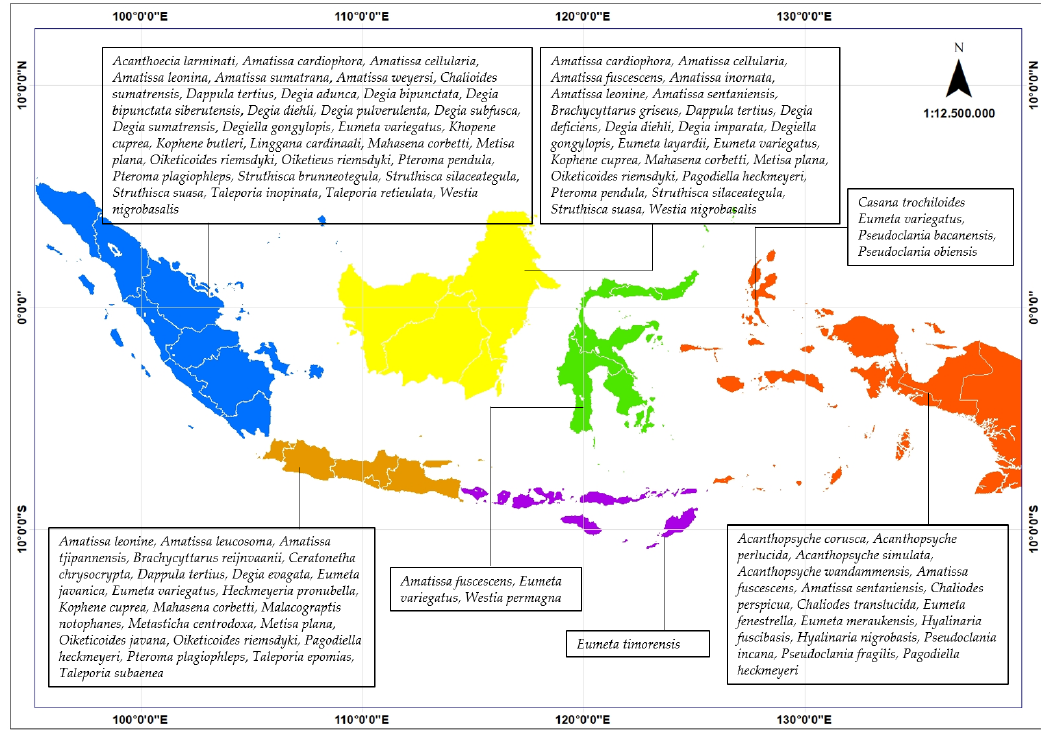
Figure 2. Distribution of bagworm species in Indonesia. Different colors represent different Islands. Data source